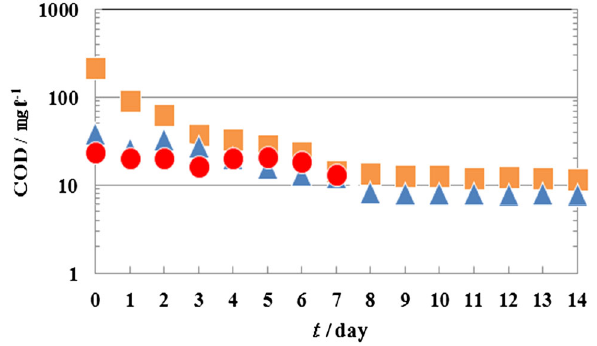
Fig. 4 COD determined for artificial seawater during the purification test with ( red circles ) and without living tropical fishes ( blue triangles ). Brown squares were determined separately using separate artificial waste water containing